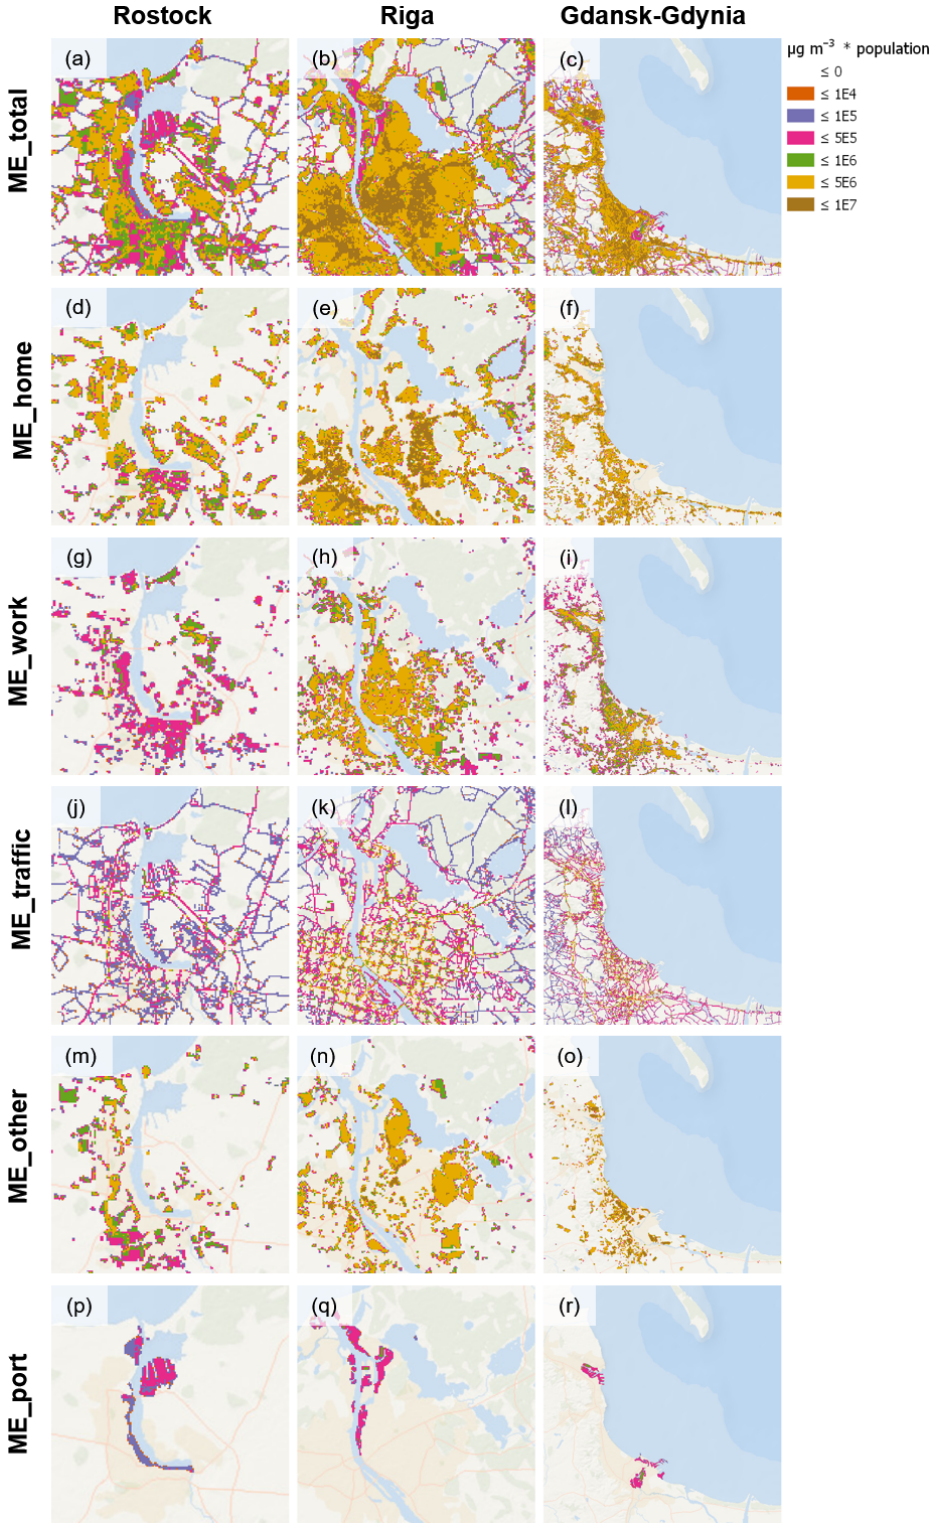
Figure 9. Exposure to NO 2 from all sources in all microenvironments and urban domains. Maps are created using © 2018 ESRI Inc. ArcGIS Pro 2.3.2 with a topographic base map by Esri, GEBCO, NOAA, National Geographic, Garmin, HERE and other contributors.